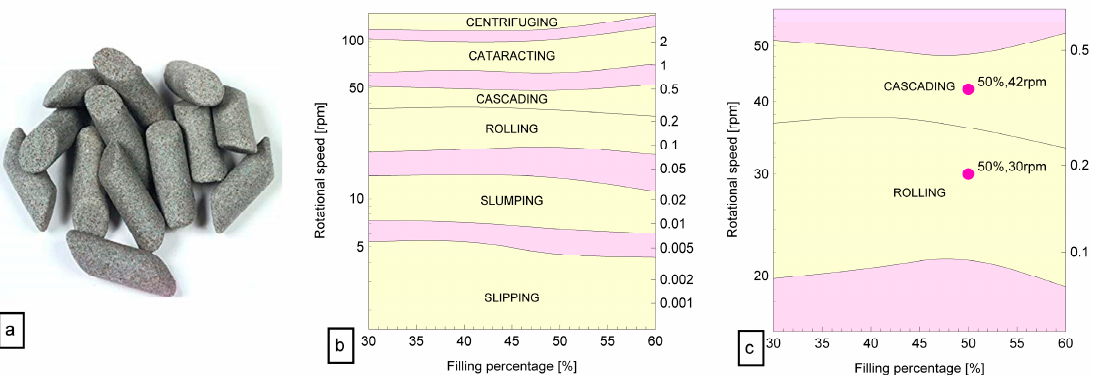
Figure 3. ( a ) Used media; ( b ) Bad Behavior (BB) diagram for the experimented charge; ( c ) zoom of the BB diagram and indication of the chosen process BB diagram and indication of the chosen process parameters.